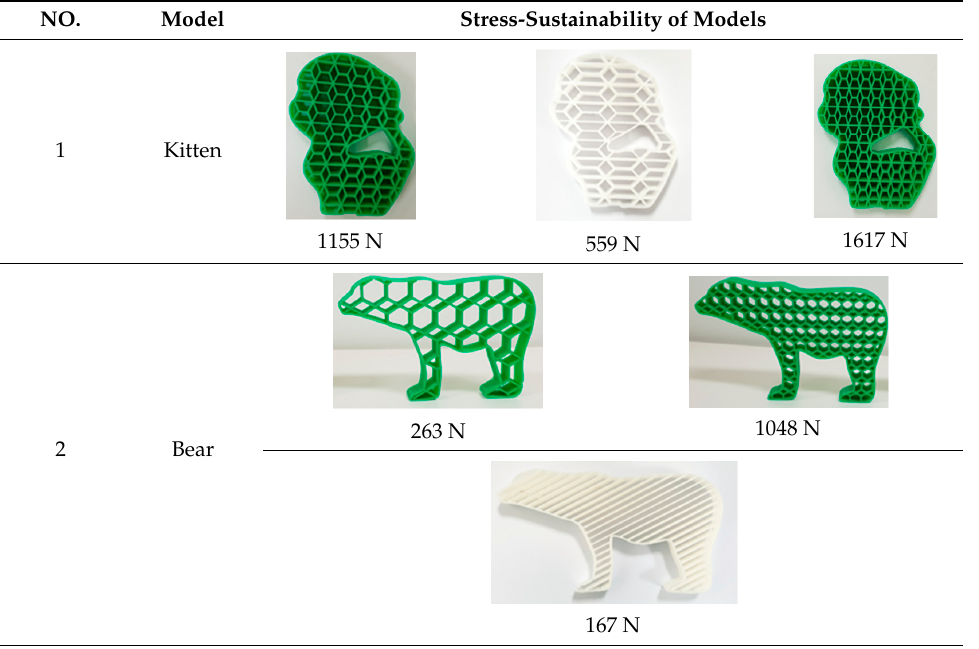
Table 2. Table Presenting Stress-Sustainability Results.